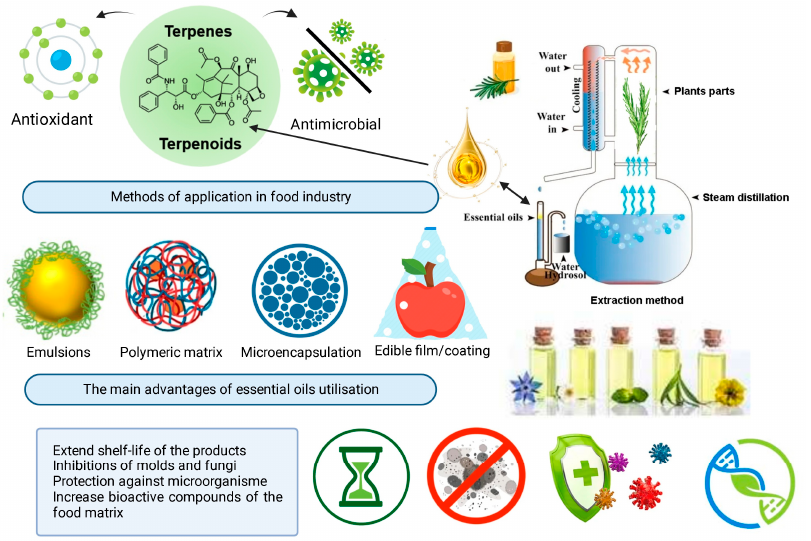
Figure 1. The steam distillation technique and principal methods of essential oils application in the food industry.